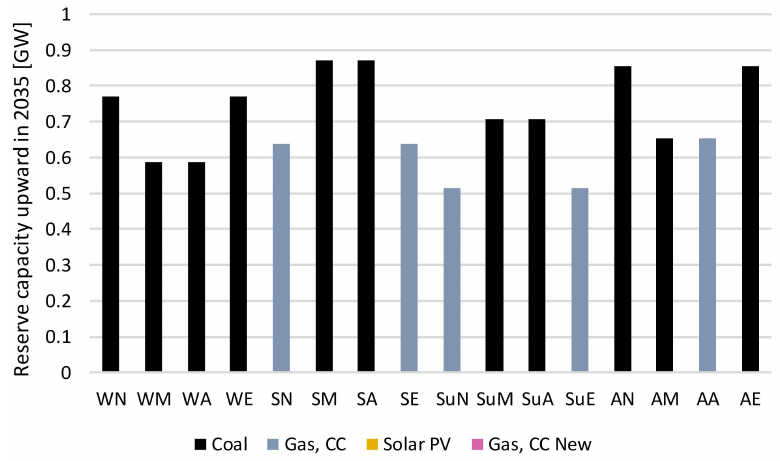
Figure 8. Reserve capacity supply (GW) in 2035 in the RETarget scenario—without code modifications.